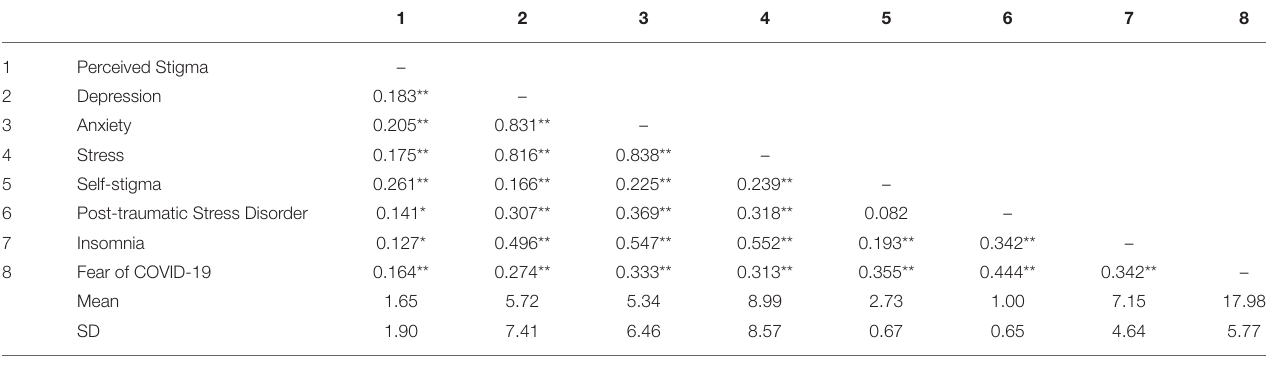
TABLE 3 | Correlation matrix among studied variables.